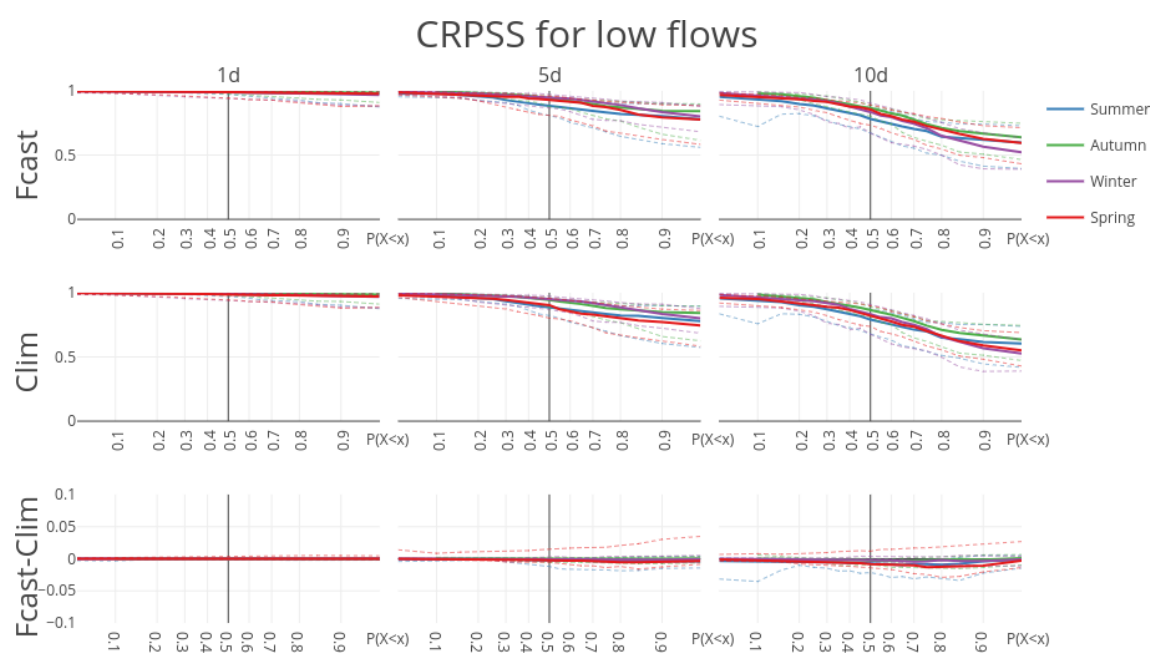
Figure 10. CRPSS for forecast runs (forecasted PET, climatological PET) and their difference benchmarked against model output for the 20 largest streams in the Rhine basin. CRPSSs are aggregated into mean (solid), 10th and 90th percentiles (dashed). Note that the CRPSS at P(X ≤ x) = 0 . 1 or 0.7 is calculated over, respectively, the 10% and 70% lowest observation–forecast pairs, conditioned on the observations.